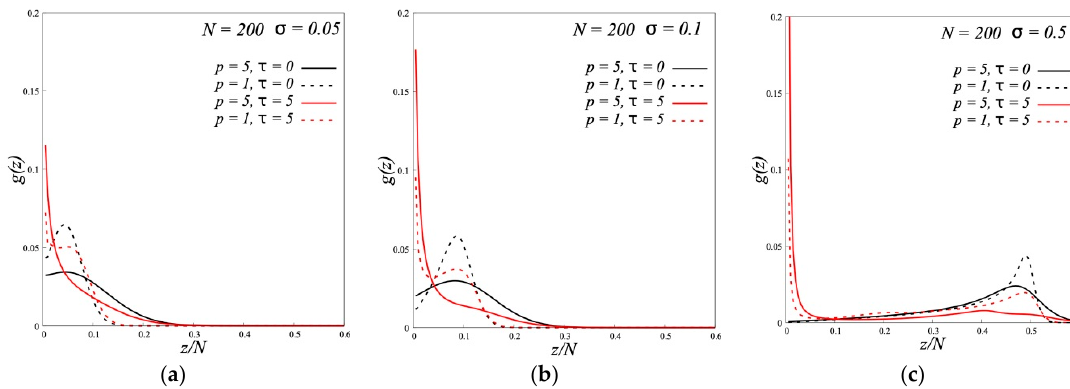
Figure 4. The end segment distributions g ( z ) in polymer brushes with different stiffness of the grafted chains ( p ) and different values of the parameter of dipole-dipole interactions ( τ ) in melt of the same chains at grafting densities σ = 0.05 ( a ), σ = 0.1 ( b ) and σ = 0.5 ( c ).